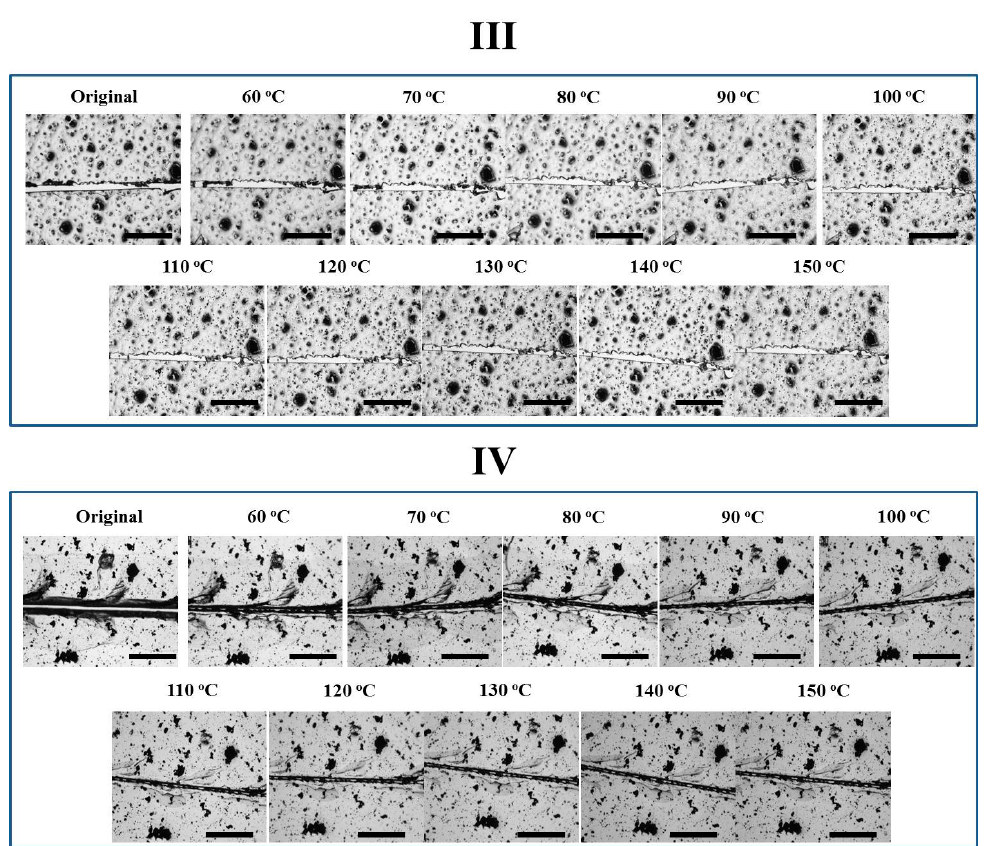
Figure 5. Optical images of the coatings with Networks III–IV under thermal treatment of different temperatures for 10 min each. The scale bar stands for 300 μ m.